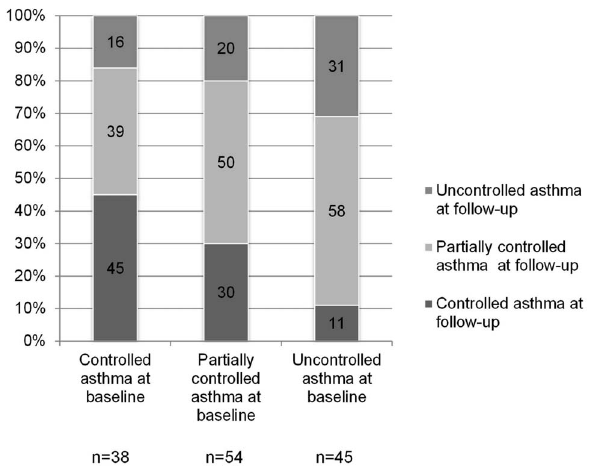
Figure 1. Distribution of GINA-based asthma control at follow- up according to GINA-based asthma control measured at baseline. The percentage of subjects in each category of GINA-based asthma control at follow up is reported inside histograms. The numbers of subjects with controlled, partially controlled and uncontrolled asthma at baseline are different from those reported in the result section due to missing data on control at follow-up. After adjusting for non-response and for the effect of covariates, the estimates of the proportion of subjects who were under control, partial control or who were not under control were 26.3%